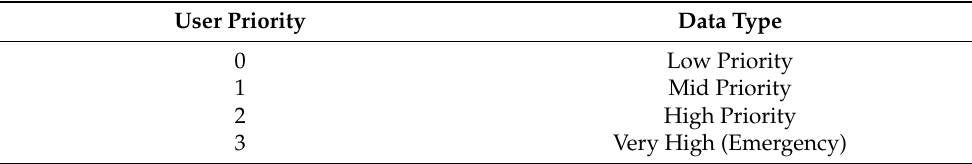
Table 2. List of user priorities.